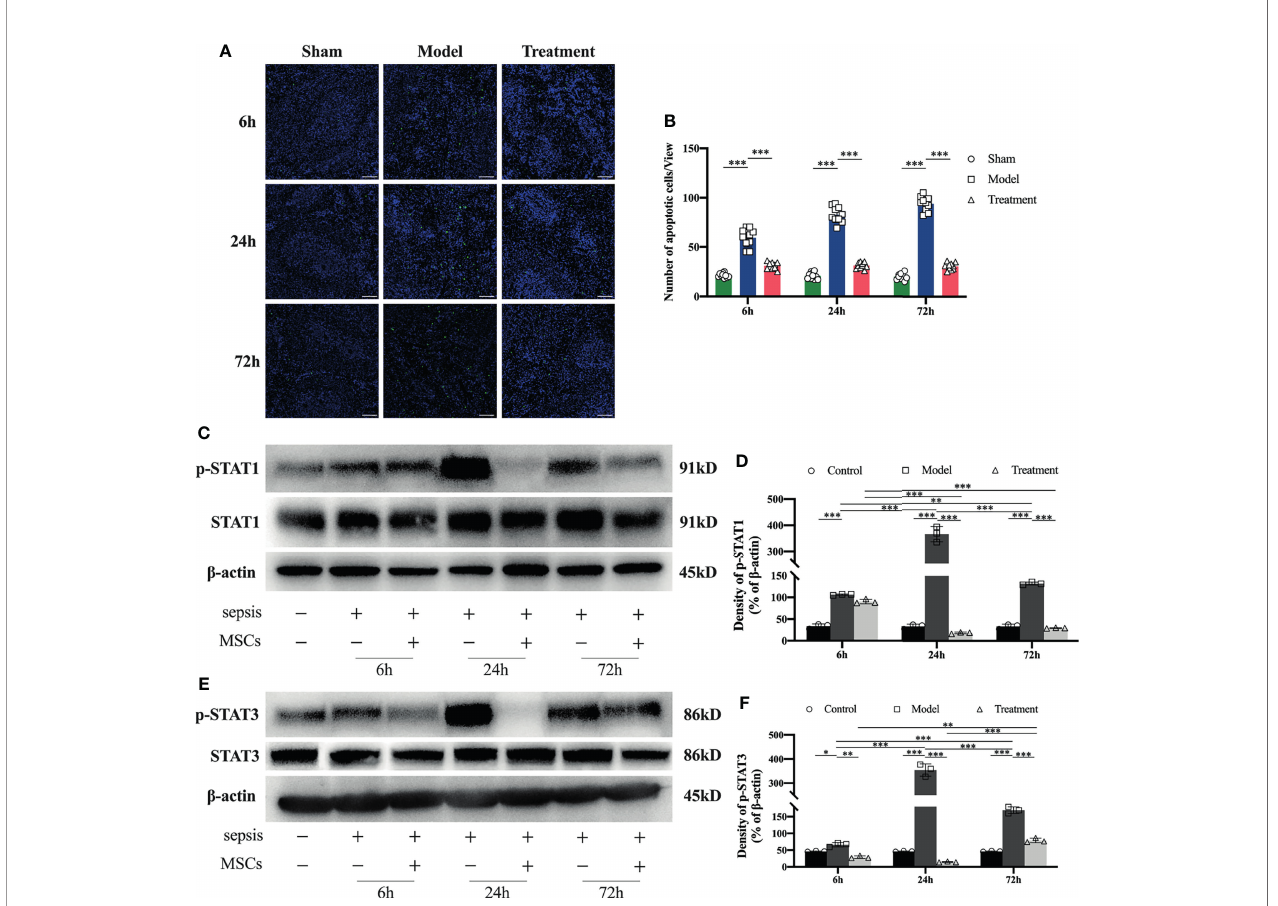
FIGURE 5 | Tunel staining and STAT1 and STAT3 expression levels in the spleen of rats in each group. (A) Apoptosis of spleen lymphocytes at 6h, 24h and 72h in each group of rats (n=5, scale bar=100mm); (B) number of apoptotic cells per fi eld of view in each group of rats; (C, D) expression levels and semi-quantitative analysis of STAT1 and p-STAT1 in spleen tissue of each group of rats (n=3); (E, F) expression levels and semi-quantitative analysis of STAT3 and p-STAT3 in spleen tissue of each group of rats (n=3). *p<0.05, **p<0.01,